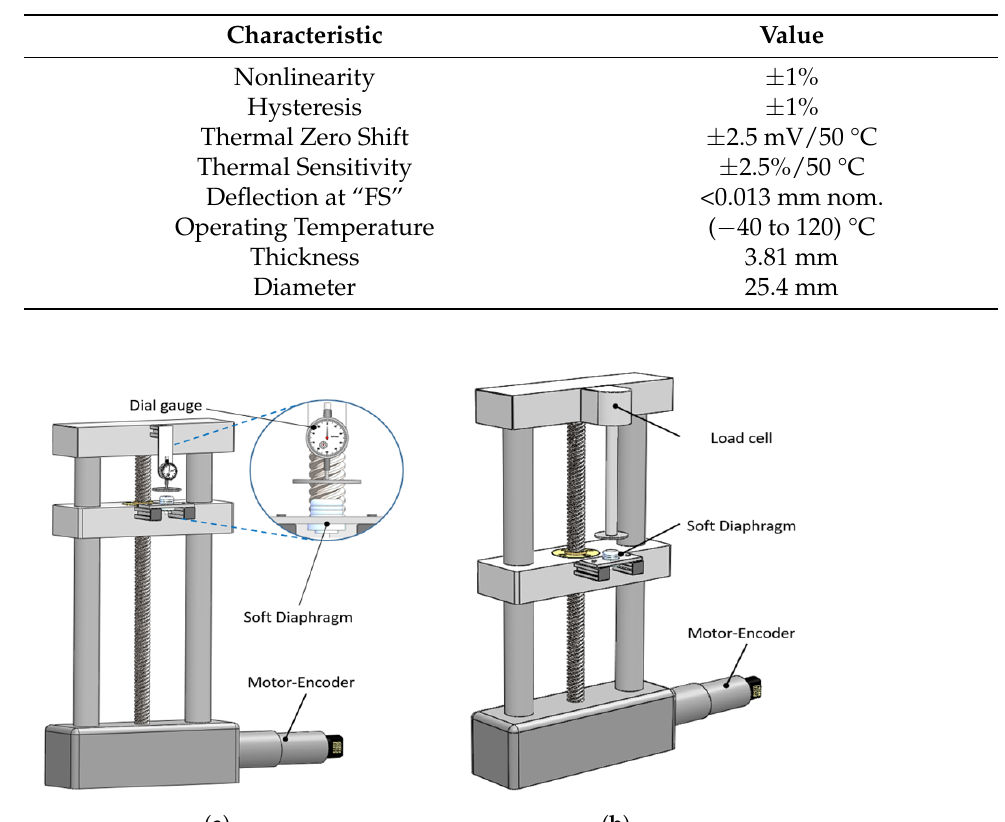
Table 2. Main technical specifications of the compression load cells.